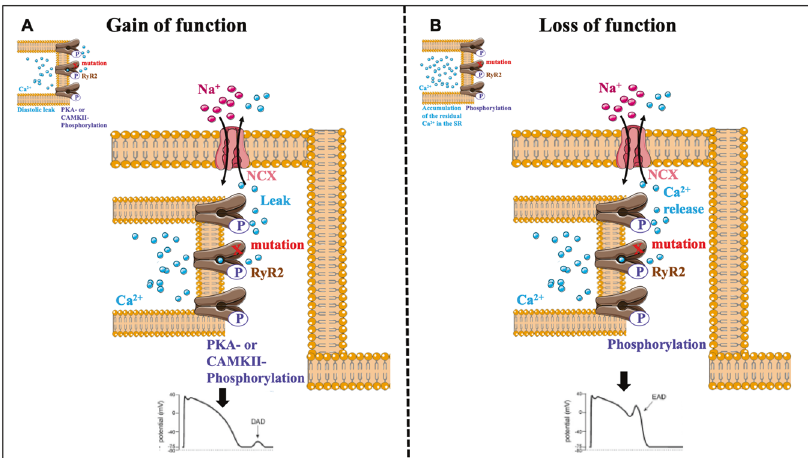
Fig. 2 Representative diagram illustrating the consequences of RyR2 gain-of-function or loss-of-function heterozygous mutations. A During diastole, the PKA- or the CaMKII-phosphorylation of the RyR2 gain-of-function mutant channels induces a SR Ca 2 + leak that increases the diastolic Ca 2 + concentration and activates the NCX exchanger. This leads to I Ti current which generates DADs and arrhythmias. B During AP, the I CaL activates the phosphorylated RyR2-WT channels that generate a normal calcium transient with a lower amplitude which in consequences, induces an accumulation of the residual Ca 2 + in the SR which gradually increases. When the SR Ca 2 + load achieves the threshold of stimulation of the phosphorylated RyR2 loss-of-function mutant channels, it releases Ca 2 + . This in turn activates the neighboring RyR2-WT enhancing thus the CICR mechanism. Hence, the Ca 2 + release through the RyR2 loss-of-function mutant channels at the end of the Ca 2 + transient induces a second phase of Ca 2 + release. It activates the NCX exchanger leading to I Ti current which generates EADs responsible of the pathogenesis of the CPVT